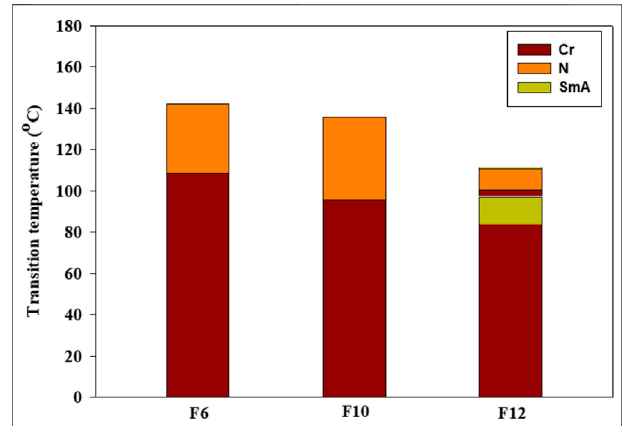
FIGURE 3 | Impact of terminal alkoxy chain length ( n ) on the mesomorphic transitions of the investigated furan derivatives, F n .